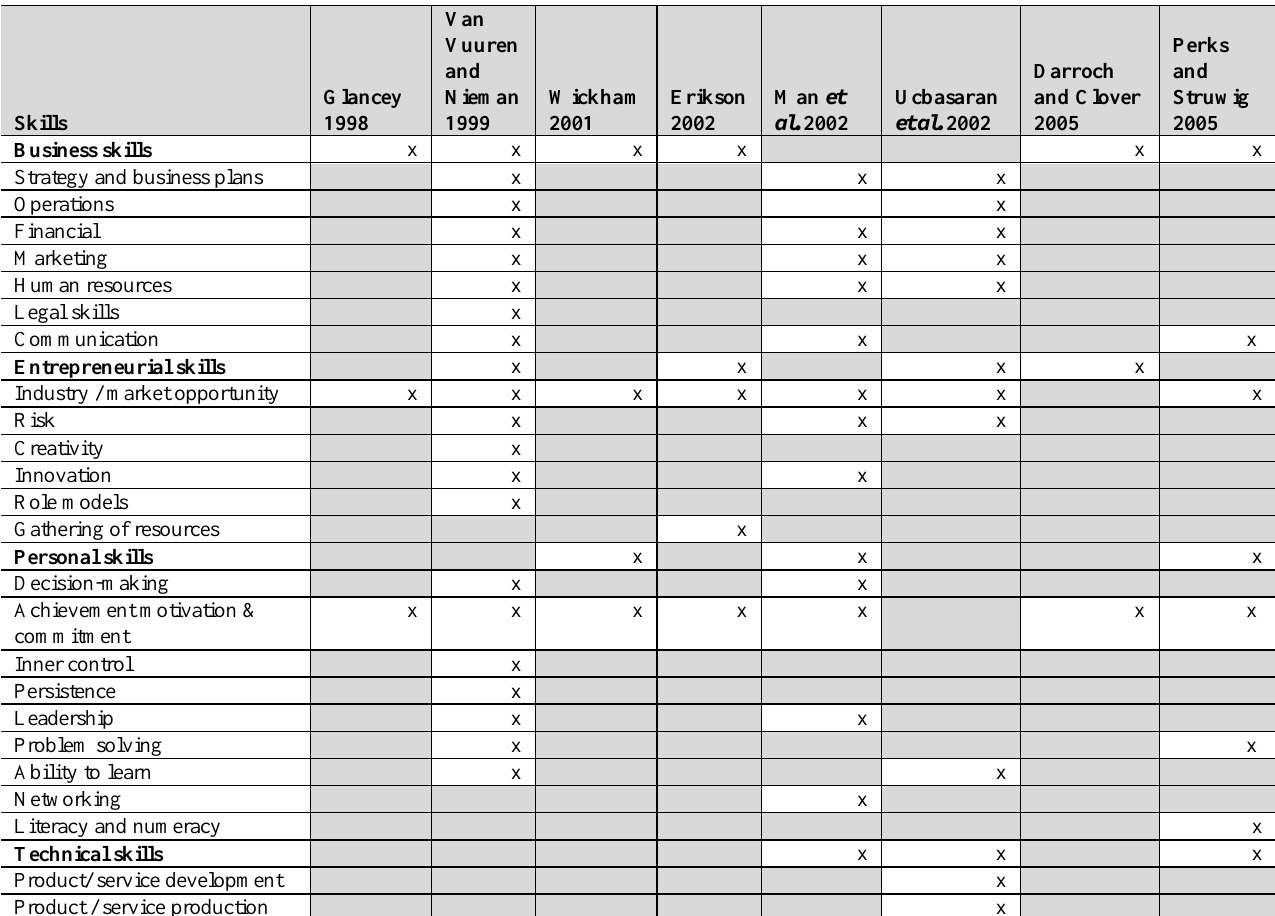
Table 2: An analysis of the skills constructs as per the eight models reviewed